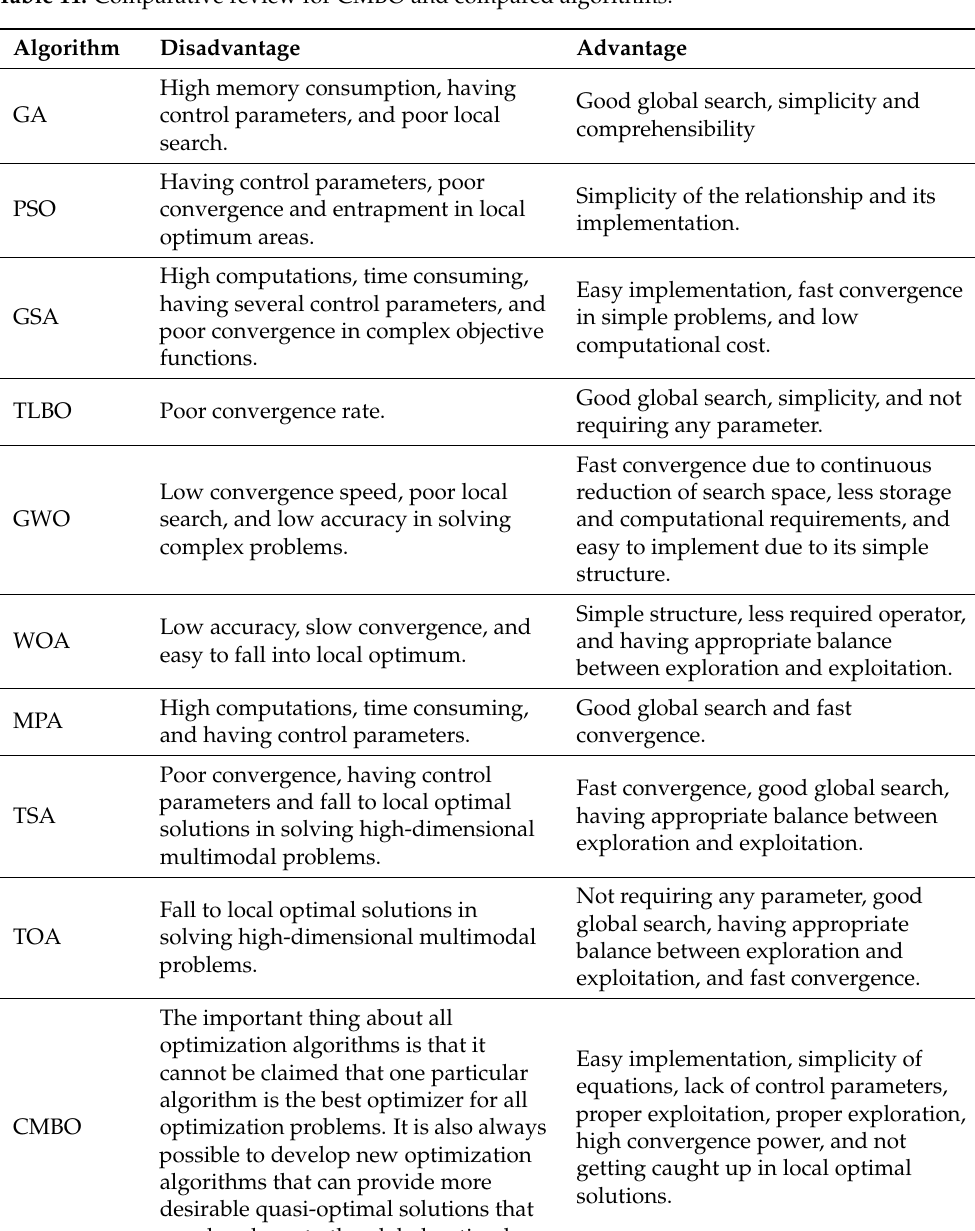
Table 11. Comparative review for CMBO and compared